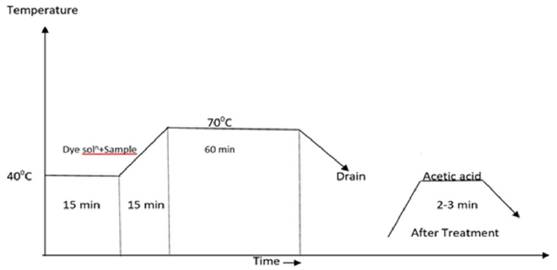
Figure 4. Graphical representation of dyeing